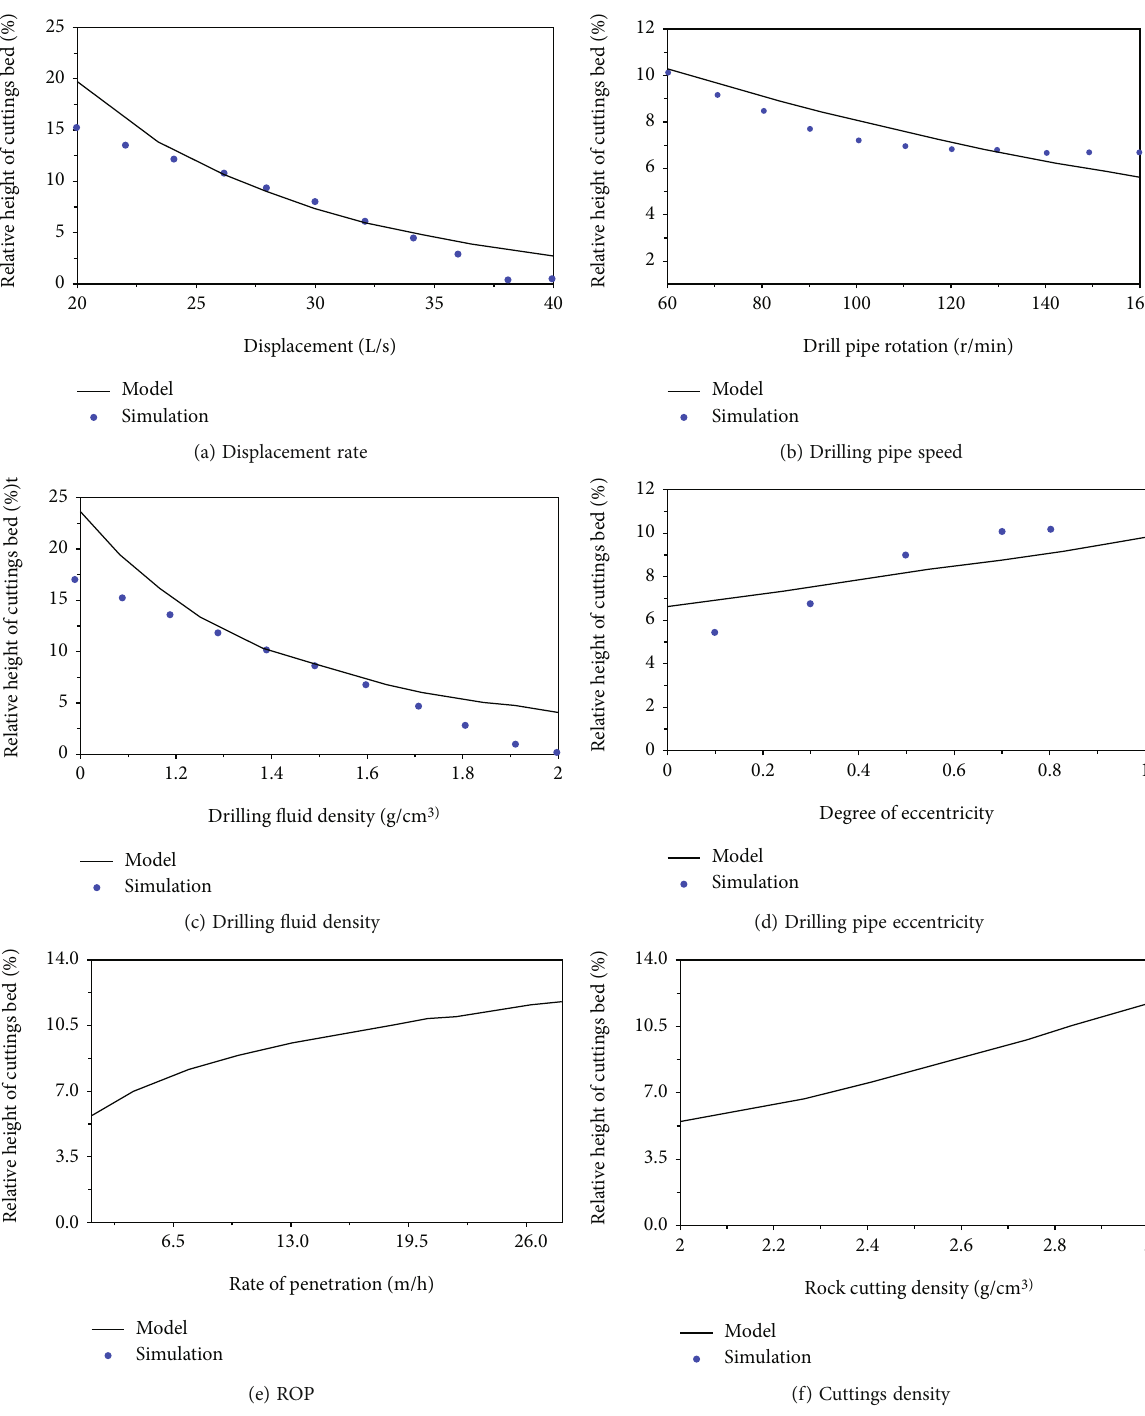
Figure 5: Relative height of cuttings bed under di ff erent in fl uence